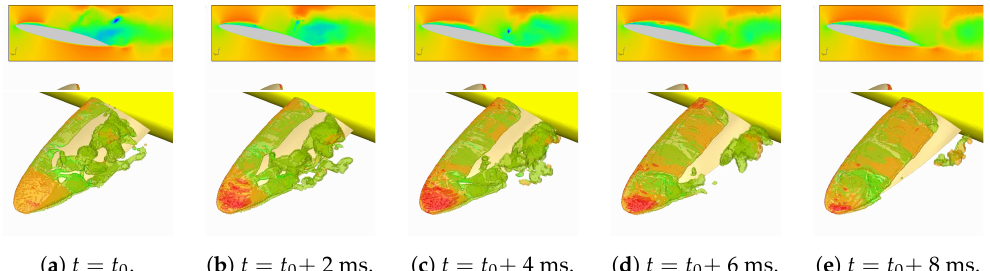
Figure 20. Visualisation of cavity growth and detachment from EE simulations. Top frames: u m / U ∞ on the y -plane at midspan. Bottom frames: Closer view of vapour phase near the left wing with cavitation volume shown as α g ∈ [ 0.1,0.9 ] coloured according to the predicted diameter of the vapour phase. Time interval between two consecutive images is 2